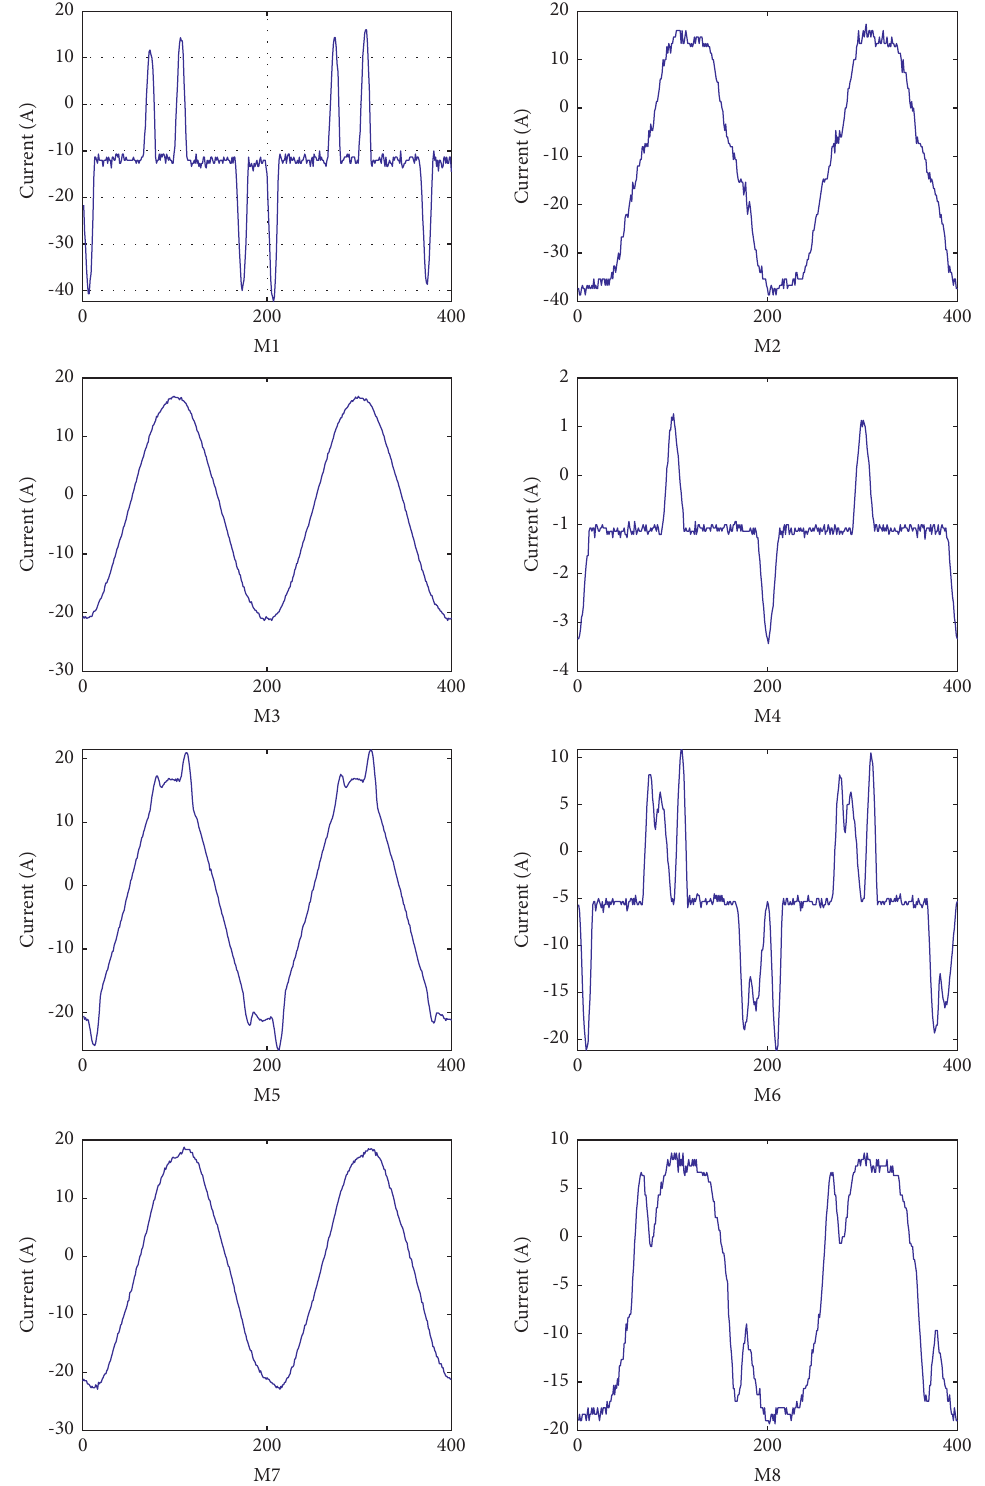
Figure 7: Steady-state current waveforms of different types of